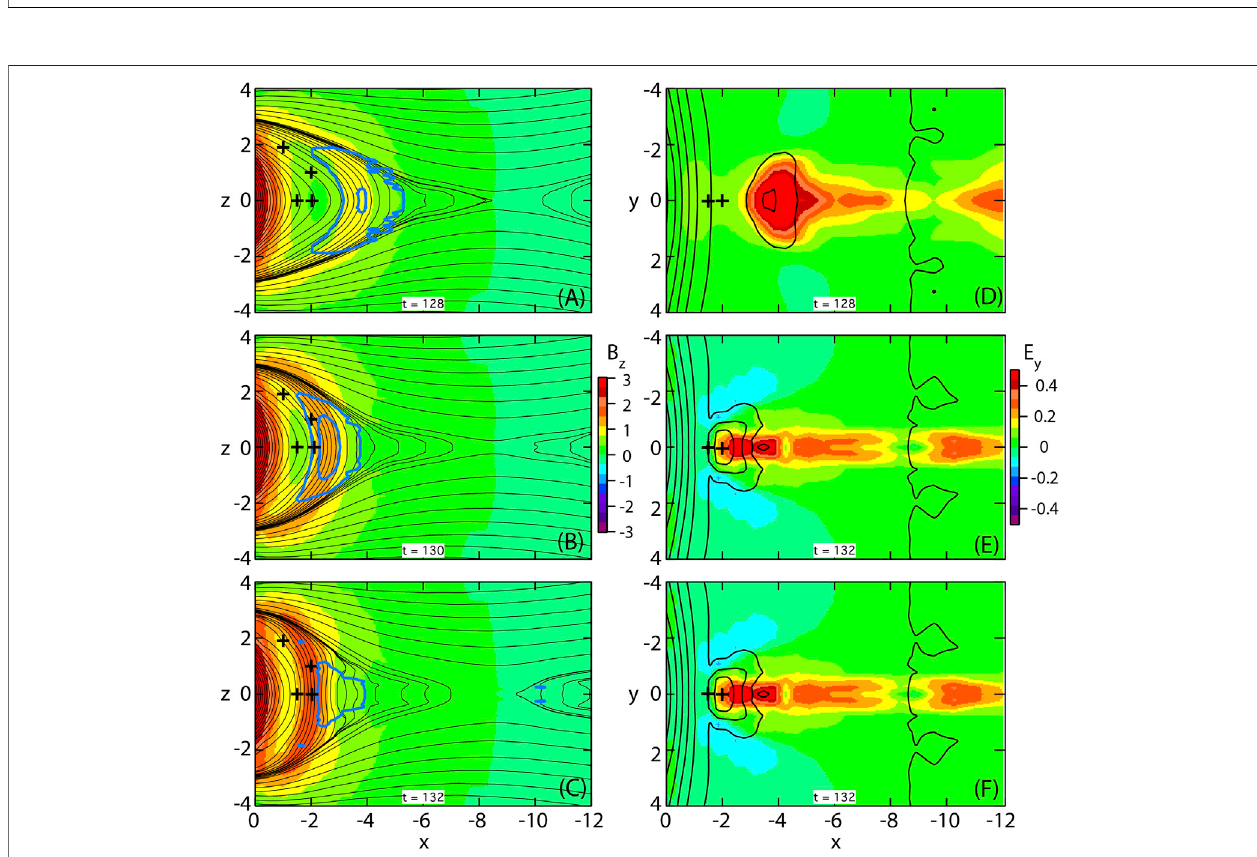
FIGURE 2 | Propagation of a DFB obtained form the MHD simulation. The left column (A – C) shows in color the magnetic fi eld component B z in the x , z plane together with magnetic fl ux contours (black lines). The heavy blue contours show the enhanced cross-tail electric fi eld at intervals of 0.4 and the plus signs indicate locations where energetic electron fl uxes are evaluated. The right column (D – F) shows in color the electric fi eld component E y in the x , y plane together with contours of B z at intervals of